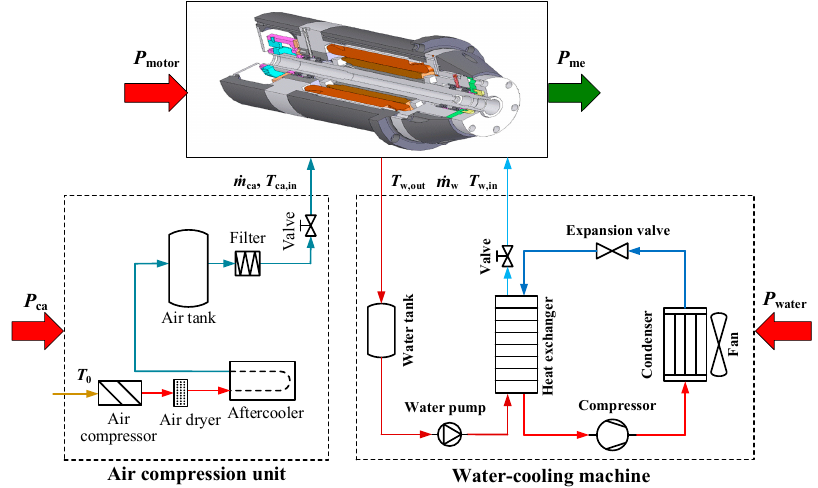
Figure 1. Energy boundaries of the motorized spindle system.